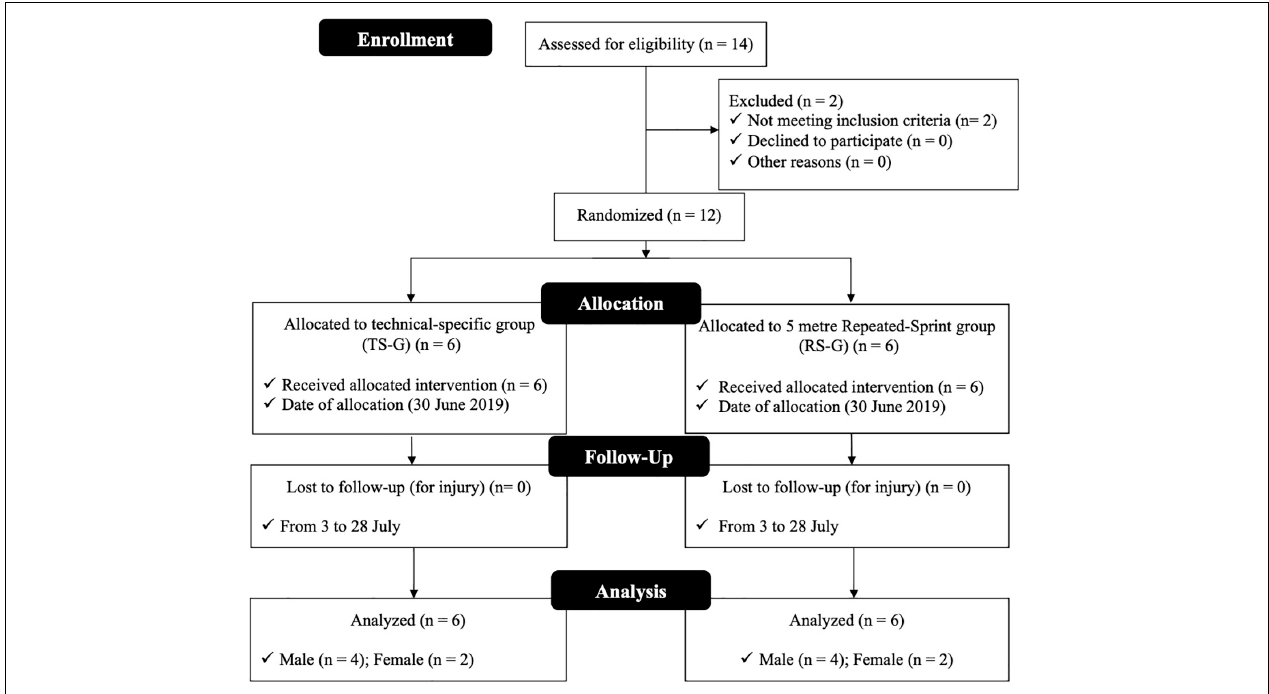
FIGURE 1 | Flowchart of the process followed in the